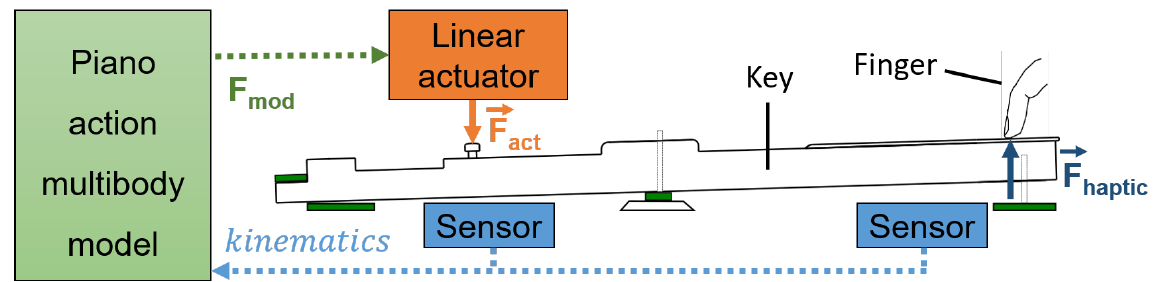
Figure 2. Haptic force feedback